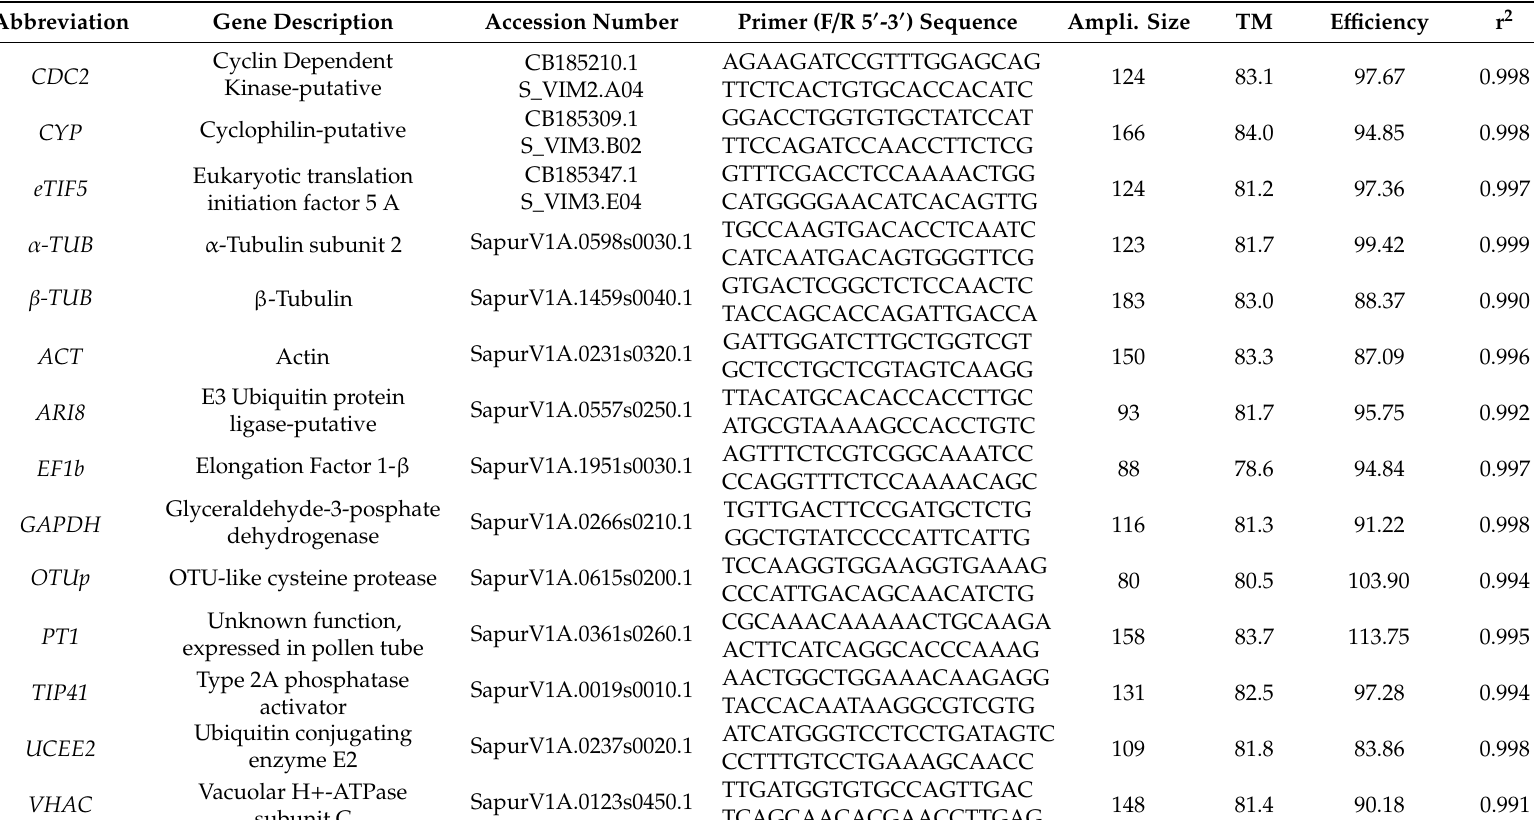
Table 2. List of candidate reference genes used in this study. Gene abbreviation, gene description, accession number, amplicon size, primer sequence, melting temperature (T M ), primer e ffi ciency, and coe ffi cient of determination (r 2 ) are given. The first three accession numbers, which correspond to S. viminalis EST, are from GeneBank; the other accession numbers are from Phytozome and correspond to S. purpurea